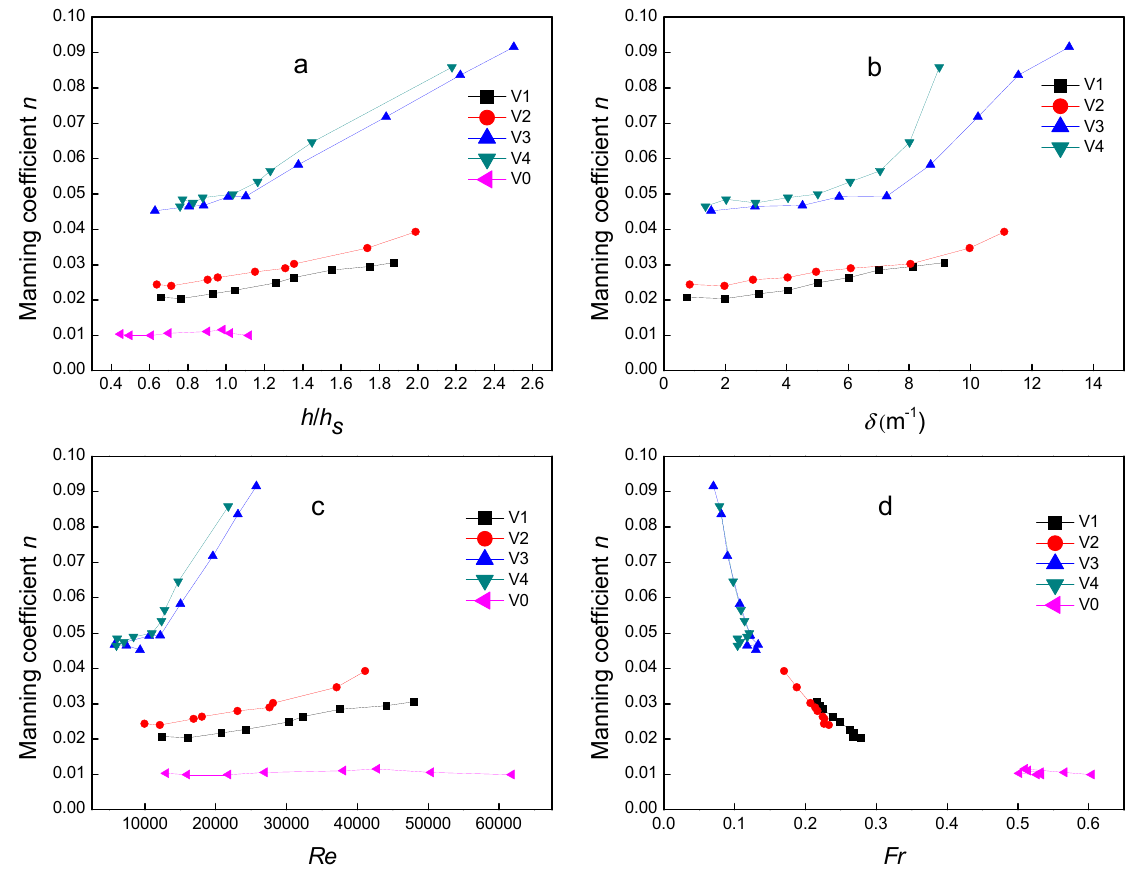
Figure 5. Manning coefficient n for each series: ( a ) n against relative depth ratio, h / h where h is the water depth and h is the plant stem height; ( b ) n against vegetation density, s δ (m − 1 ); ( c ) n against Reynolds number, Re ; ( d ) n against Froude number, Fr .